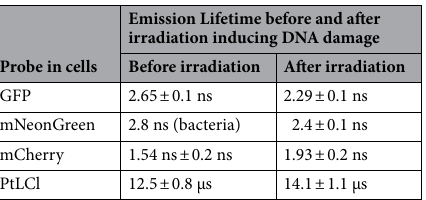
Table 1. Summary of mean changes in environmental sensing